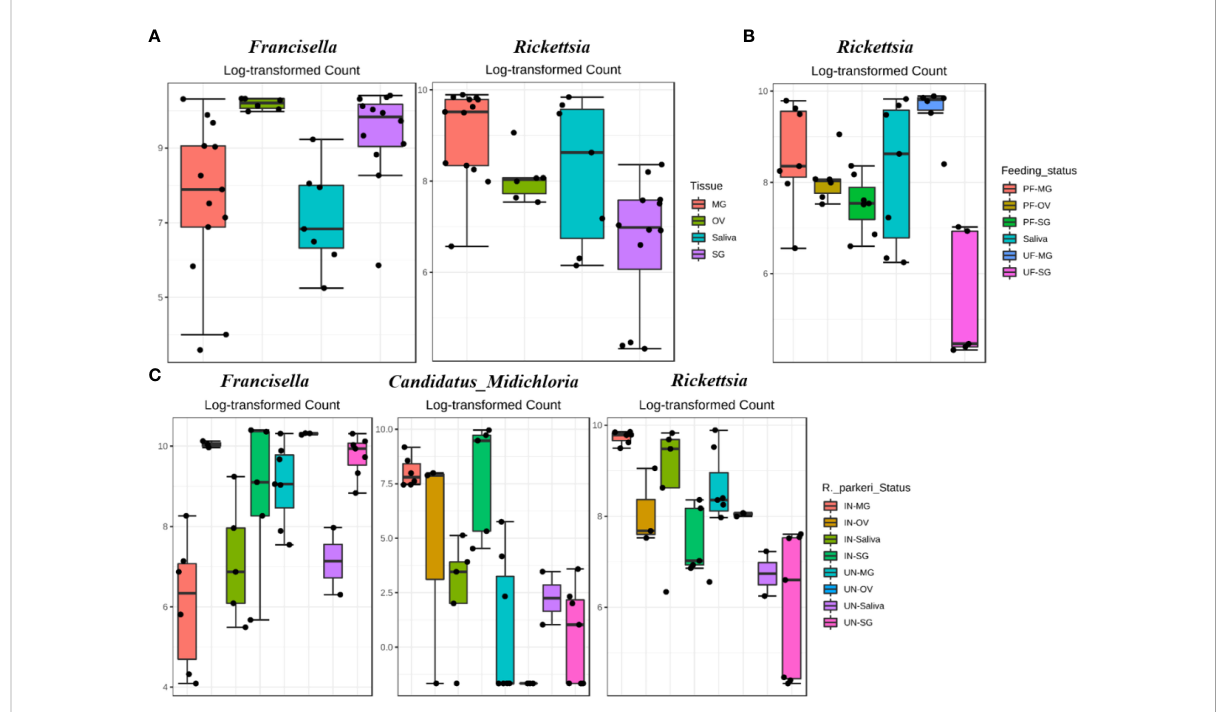
FIGURE 3 DeSeq2 differential abundance analysis of OTUs (genus-level) between (A) whole tissues (B) R. parkeri infected and uninfected, and (C) unfed and partially fed Am. maculatum. For multiple comparisons an estimate of the FDR was calculated to determine differentially abundant families with a signi fi cance threshold of p-value < 0.05. PF (partially blood fed), UF (unfed), IN ( R. parkeri infected), UN